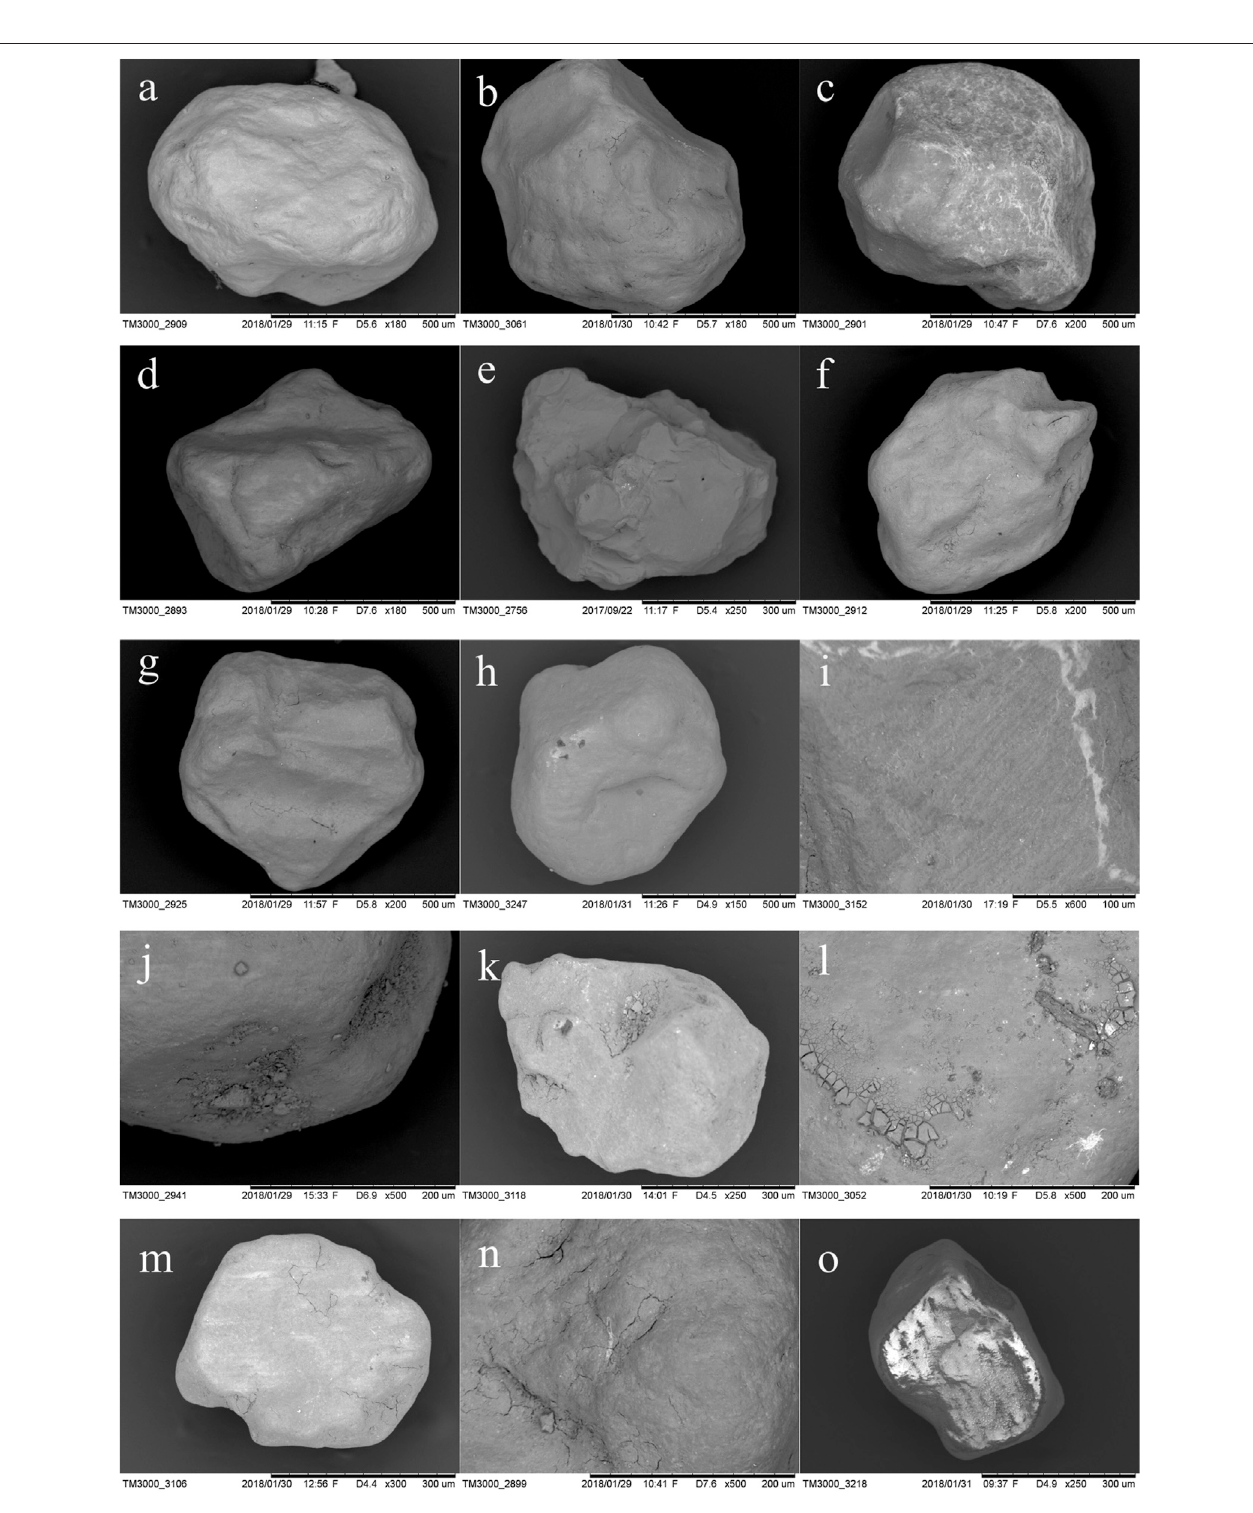
FIGURE8| TypicalsurfacemicrostructuresforquartzgrainsintheMuUsSandyLand. (A) RoundedgrainfromthesouthwestregionoftheMuUsSandyLand. (B) rounded grain showing butter fl y-shaped pits. (C) pitted surface. (D) crescent-shaped pits. (E) conchoidal fractures produced in the high-energy subaqueous environment. (F) large V-shaped fractures with high relief indicates a typical subaqueous environment. (G) straight grooves. (H) curved grooves; (I) parallel striations. (J) rounded grains with silica globules. (K) sub-angular grains showing silica fl owers. (L) silica fl owers. (M) angular grains with solution crevasses. (N) solution crevasses founded around silica globule. (O) silicon compounds.